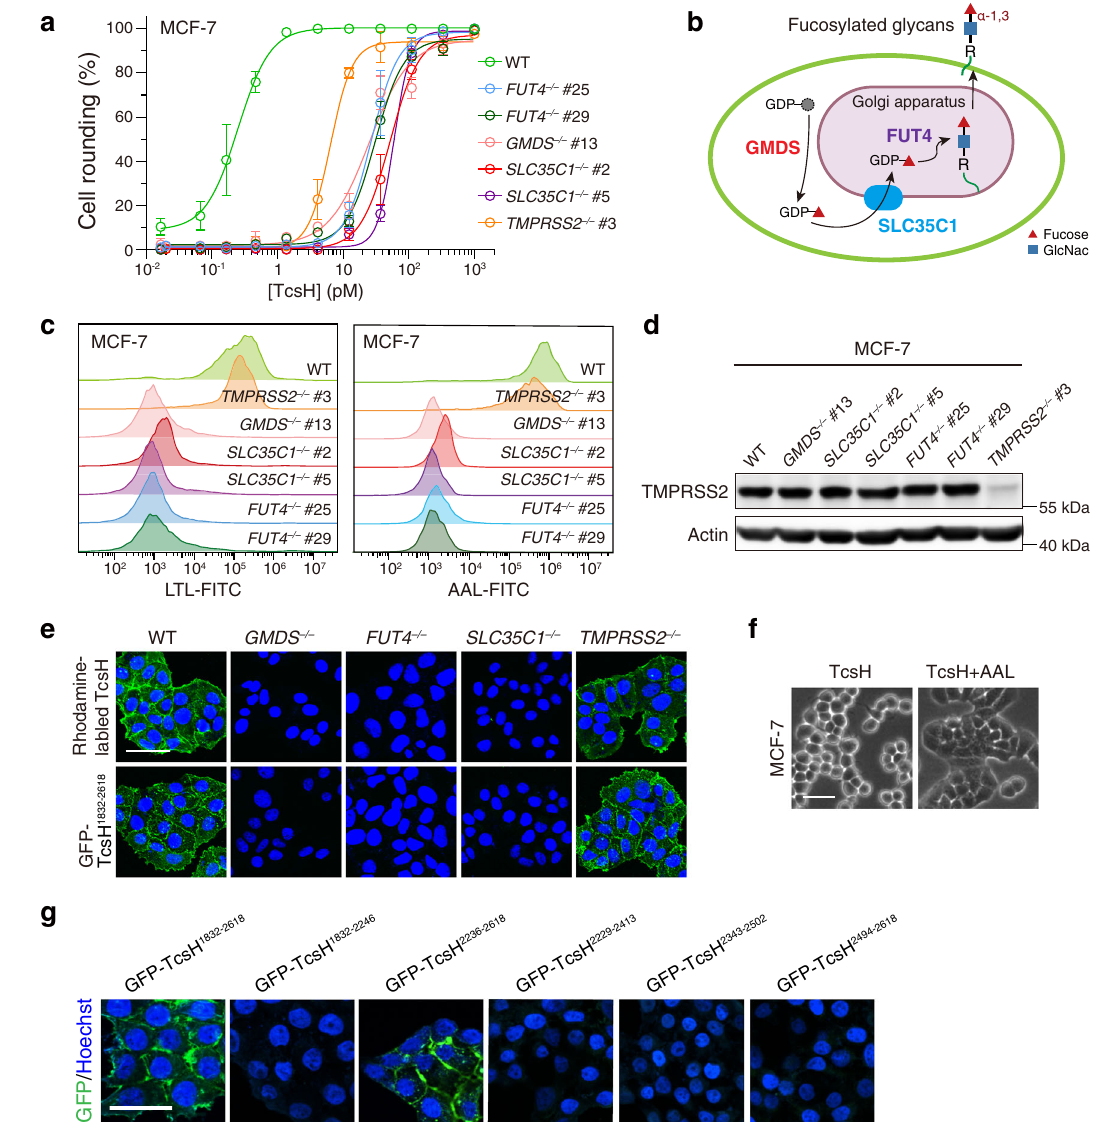
Fig. 2 | Cell surface fucosylation mediates the binding/entry of TcsH. a The sensitivities of MCF-7 TMPRSS2 ‒ / ‒ , GMDS ‒ / ‒ , FUT4 ‒ / ‒ , and SLC35C1 ‒ / ‒ cell lines to TcsH weremeasuredusingthecytopathiccell-roundingassay.Errorbarsrepresentmean ± s.d., n =6. b Schematic view of biosynthesis of fucosylated glycans, genes iden- ti fi ed from the screens were highlighted. c Flow cytometry pro fi les of fl uorescein isothiocyanate(FITC)-conjugatedLTL(left)orAAL(right)bindingtoMCF-7WTand KO cells. d The absence of TMPRSS2 expression in the MCF-7 TMPRSS2 ‒ / ‒ cells was validatedbyWesternblotanalysis. TheMCF-7 GMDS ‒ / ‒ , FUT4 ‒ / ‒ ,and SLC35C1 ‒ / ‒ cells have similar TMPRSS2 expression levels compared to the WT cells. The